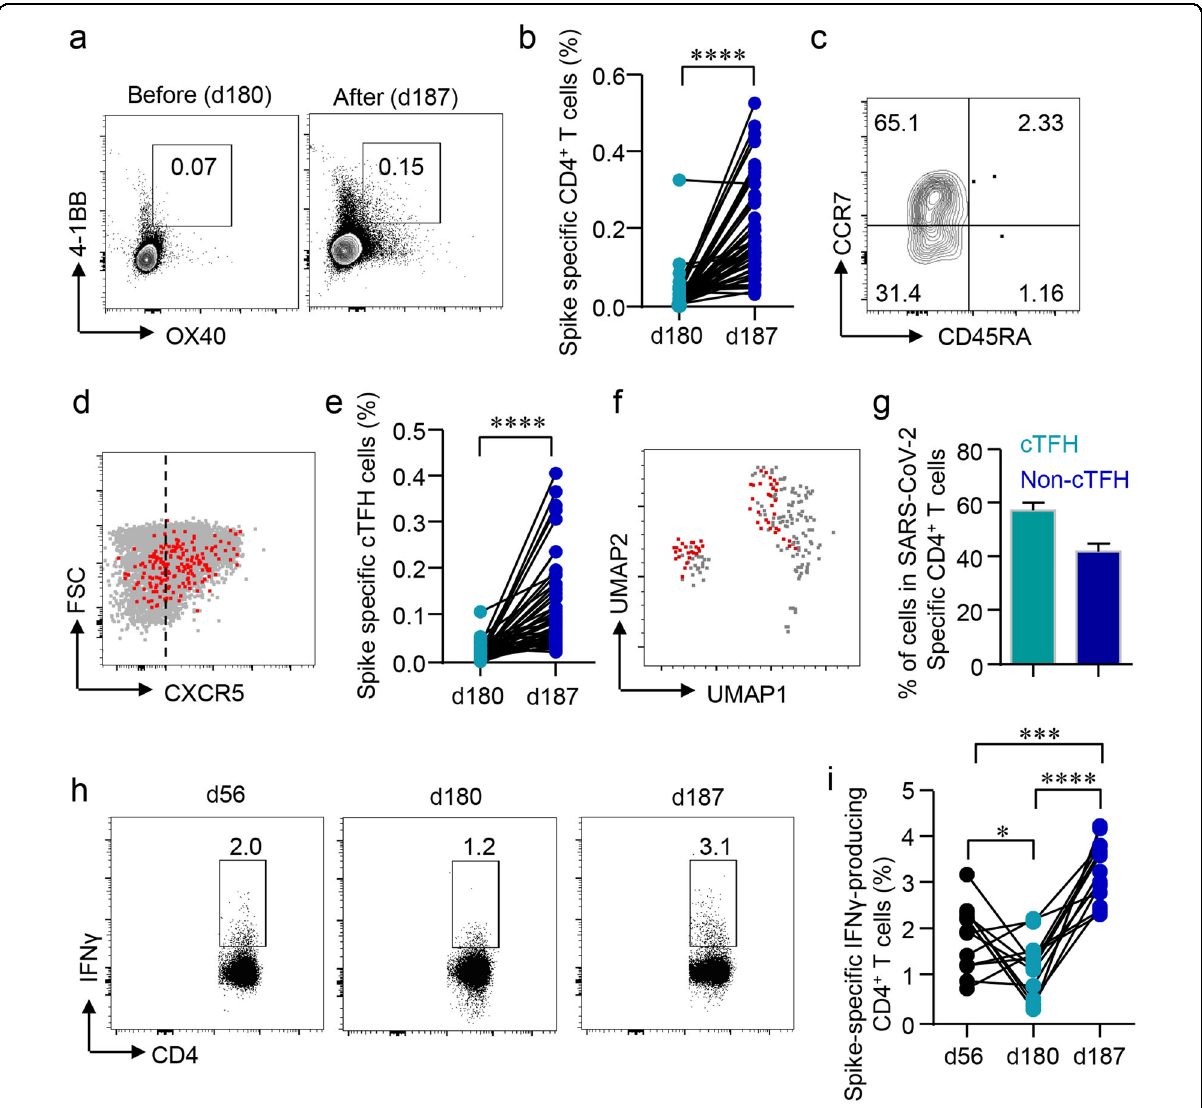
Fig. 4 Rapid induction of CD4 + T cells by the third dose. a , b Activation-induced markers (AIM) OX40 and 4-1BB in CD4 + T cells were